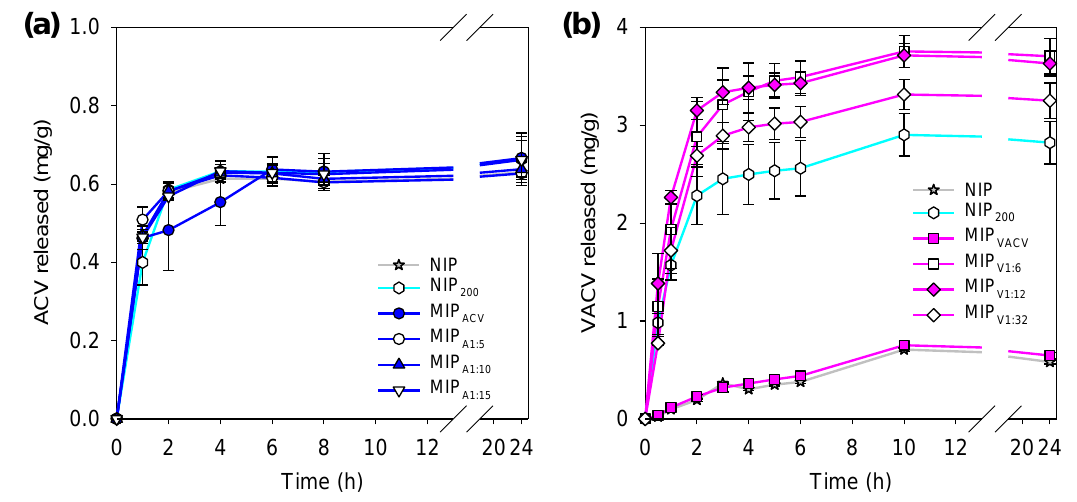
Figure 5. Release profiles of ( a ) ACV and ( b ) VACV from non-imprinted and imprinted hydrogels in simulated lacrimal fluid (SLF).